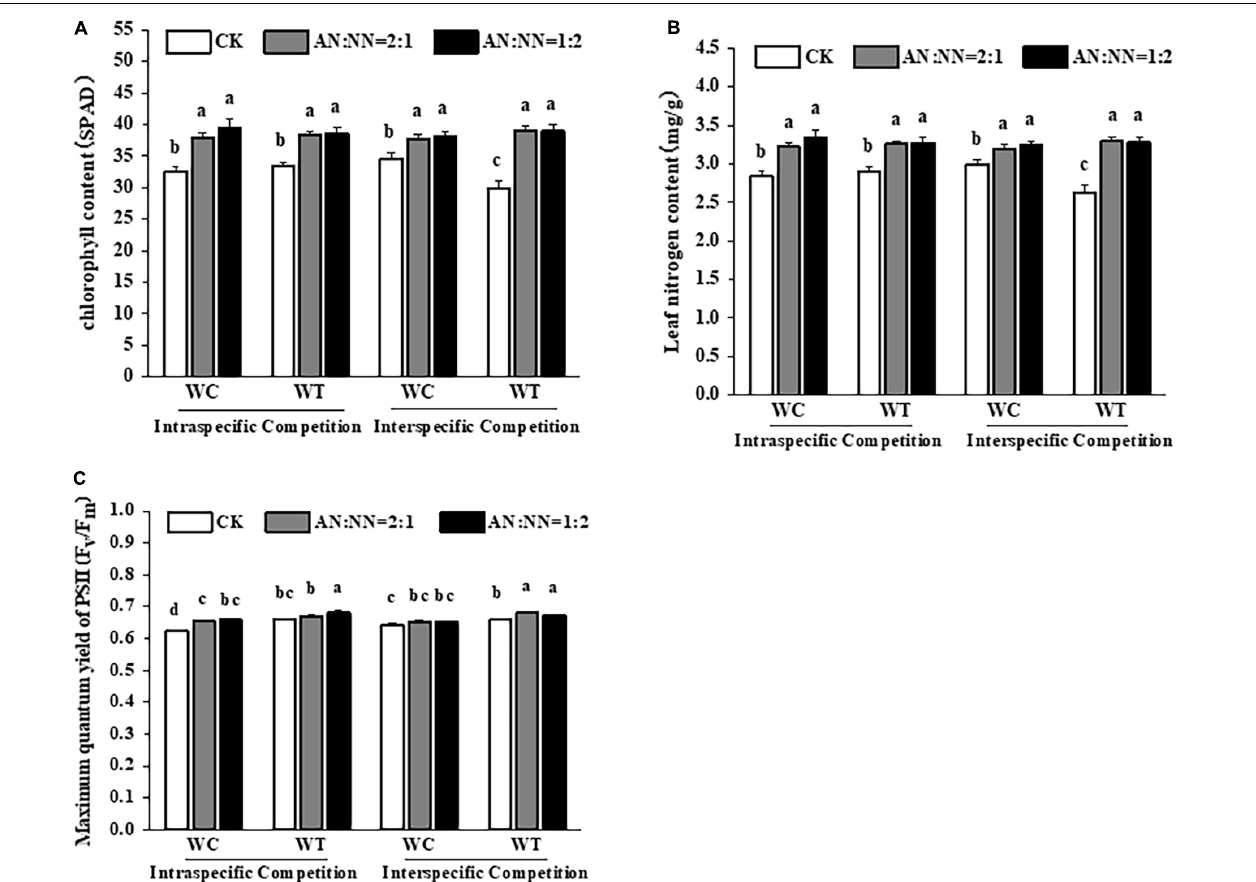
FIGURE 4 | Effects of different N forms and competitive treatments on plant photosynthesis traits under high N conditions. WT, W. trilobata ; WC, W. chinensis ; CK, no nitrogen addition; AA, ammonium nitrogen; NN, nitrate nitrogen; N15(2:1), nitrogen form ratio AN:NN, 2:1 with total nitrogen amount of 15 g N · m − 2 · year − 1 ; N15(1:2), nitrogen form ratio AN:NN, 1:2 with total nitrogen amount of 15 g N · m − 2 · year − 1 ; (A) chlorophyll content; (B) leaf nitrogen content; (C) maximum quantum yield of PSII (mean ± SE, n = 3). Different lowercase letters above bars indicate significant differences between different treatments ( p <